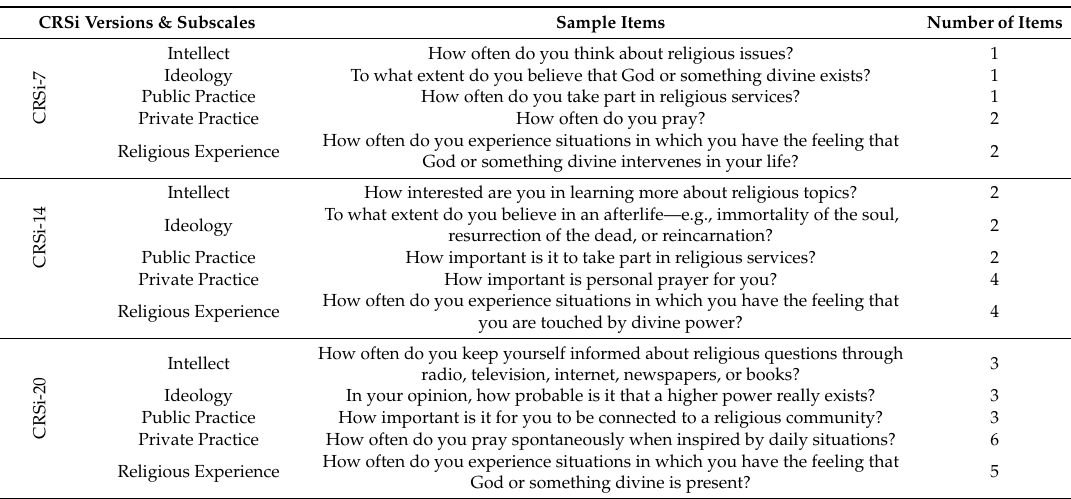
Table 1. CRSi-7, CRSi-14, & CRSi-20 Subscales & Sample